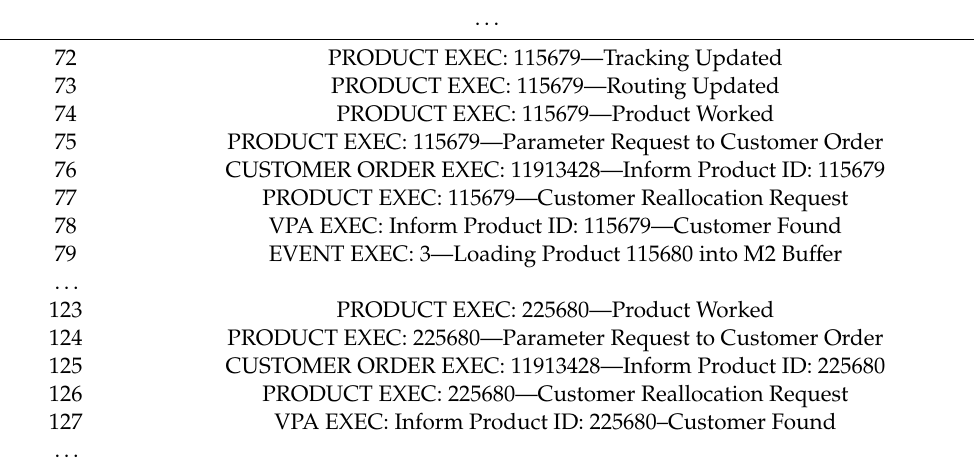
Table 10. Extract of the simulation log with the messages of the